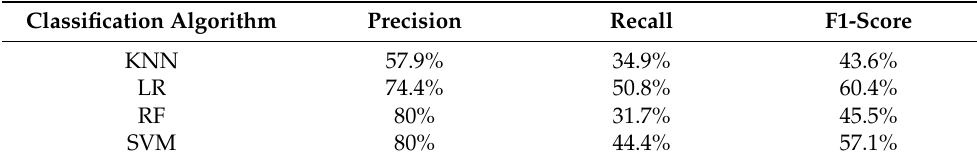
Table 2. Precision , recall , and F 1- score of KNN, LR, RF, and SVM on pre-processed sample data.